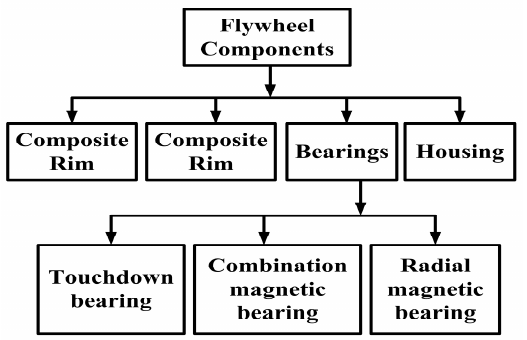
Figure 34. Basic flywheel components. The flywheel is suspended in tis hosing by bearings, and is connected to a motor-generator to store and supply energy [61]. Table 12. Characteristics of different materials used for flywheels [62].